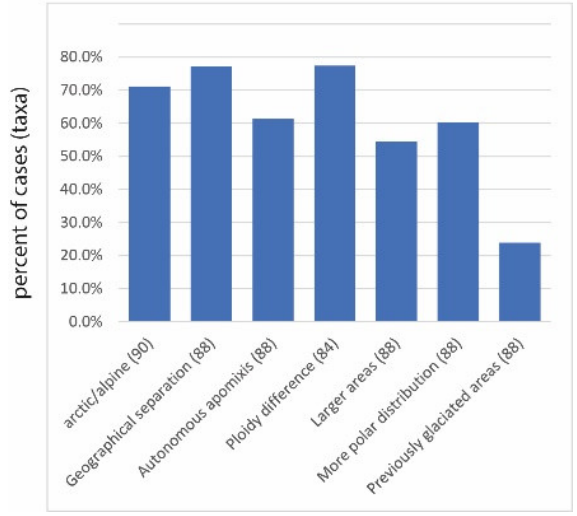
Figure 1. Percentages of taxa (no. of respective total cases in parentheses, based on presence/absence matrix of occurrences in Supplementary Table S1) with (at least partial) arctic/alpine distribution, geographical separation of apomicts and sexuals, autonomous apomixis, ploidy difference between sexuals and apomicts, larger areas of apomicts than sexuals, apomicts with a more polar (north- ern/southern) distribution than sexuals, and exclusive occurrence of apomicts in previously glaciated areas (see references in Table 1).